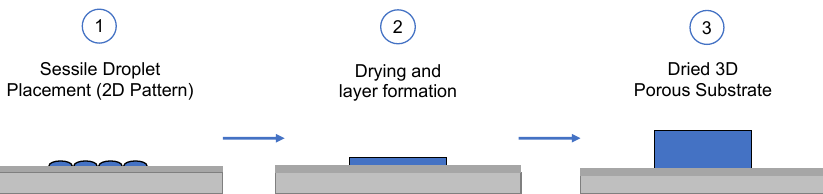
Figure 1. Simplified scheme of porous substrate formation by layer-by-layer build-up from single droplet deposits (repeated execution of steps 1 and 2). The liquid of the droplets is evaporated into a heated gas.